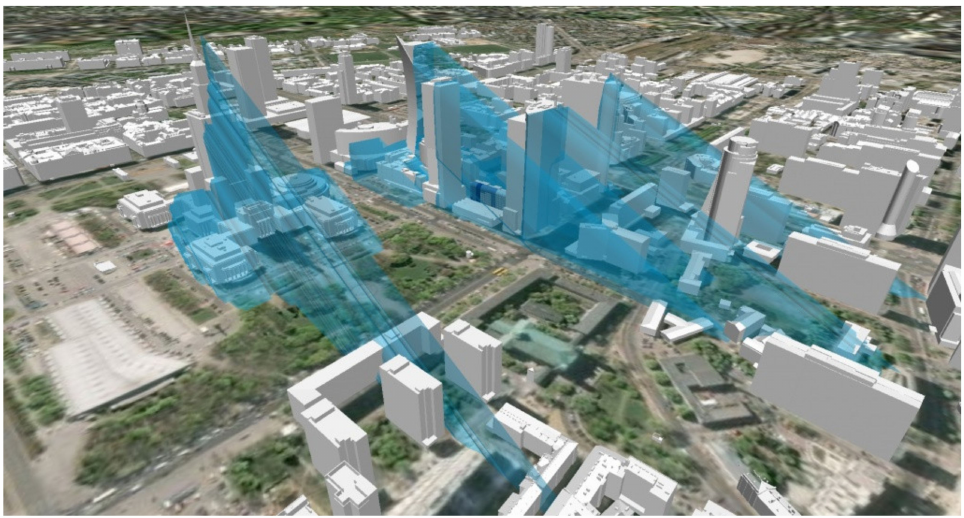
Figure 17. Shadow solids (in blue) generated in the morning for a selected part of buildings in the centre of Warsaw on a selected day of March